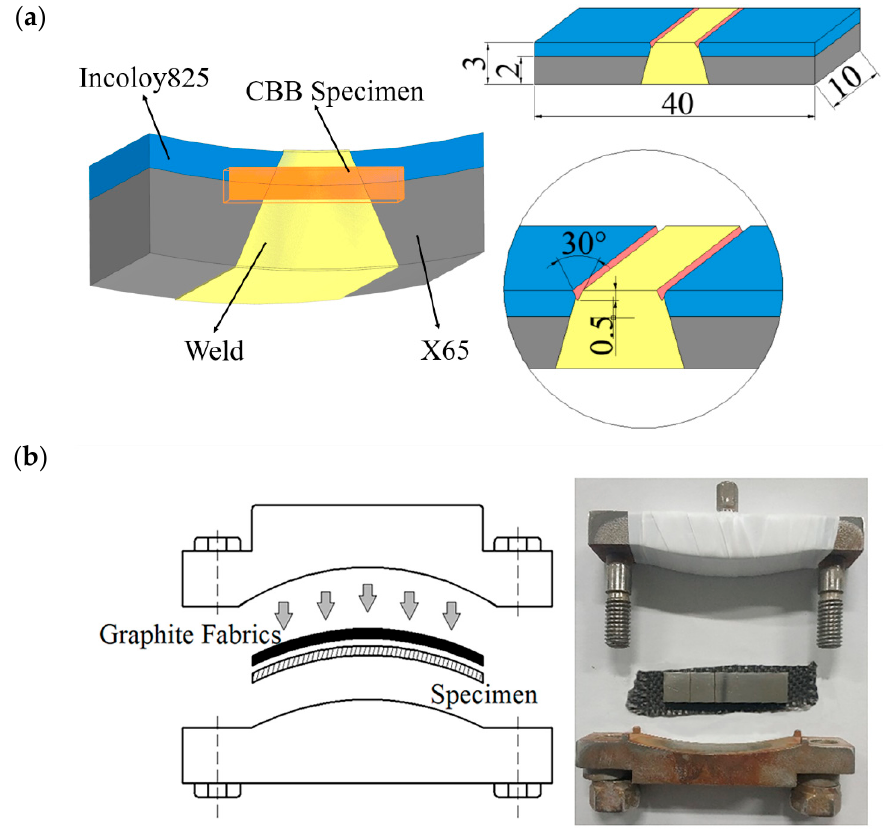
Figure 3. Schematic diagram of CBB test: ( a ) schematic diagram of CBB specimen(unit: mm); ( b ) diagram of experimental apparatus.